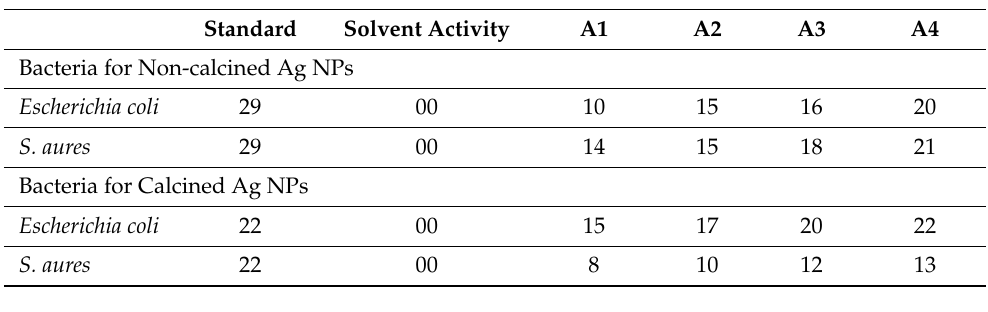
Table 1. Antimicrobial activities of Ag NPs against different microbes, where Al = 20 mg/mL, A2 = 40 mg/mL, A3 = 60 mg/mL, and A4 = 80 mg/mL. Zone of Inhibition (ZOI) Measure in Millimeters (mm)